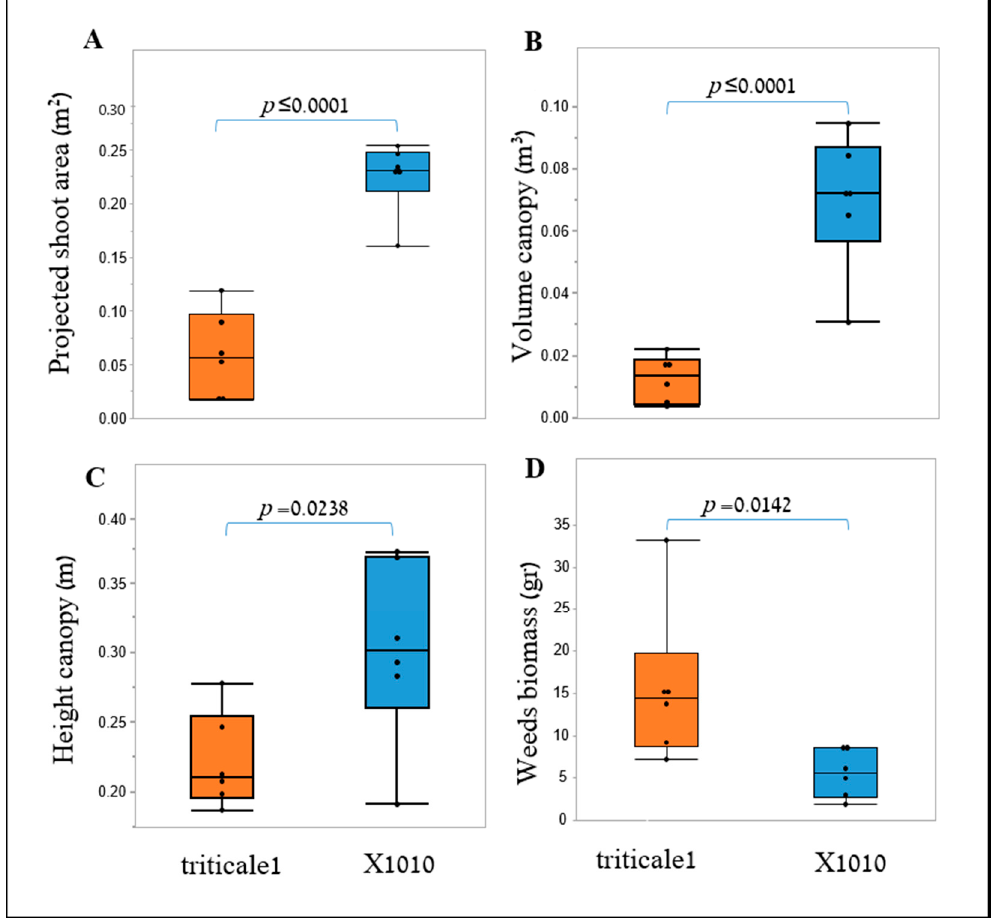
Figure 9. Results of the field conditions competition experiment. Compression between X-1010 ( blue ) and Triticale1 ( orange ) genotype ( A ) projected shoot area (PSA), ( B ) volume, ( C ) height, and ( D ) resulted in weed biomass. p -values were determined by t -test ( n = 6) between the X-1010 and the Triticale1 genotype.